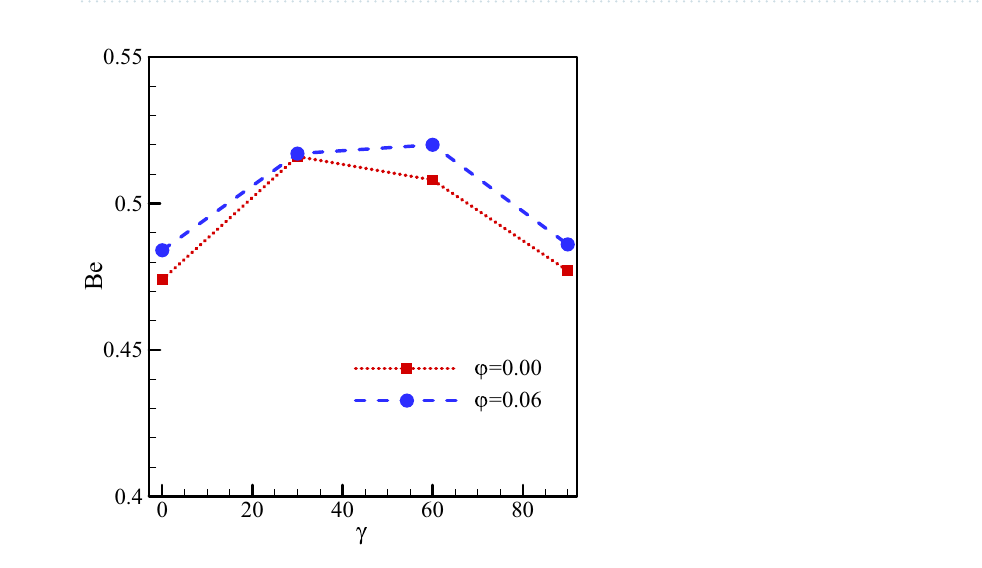
Figure 17. Bejan number for Ra = 10 5 , ω = 0, Ha = 20, Rd = 1 and various nanofluid concentrations and cavity